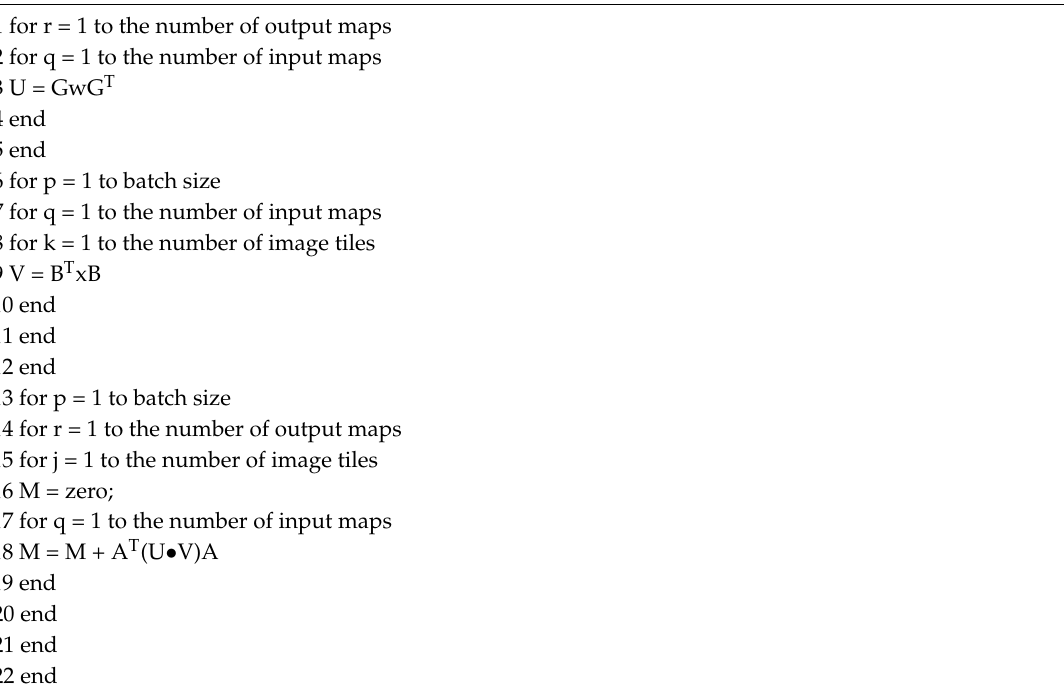
Algorithm 1. Implementation of the Winograd algorithm.